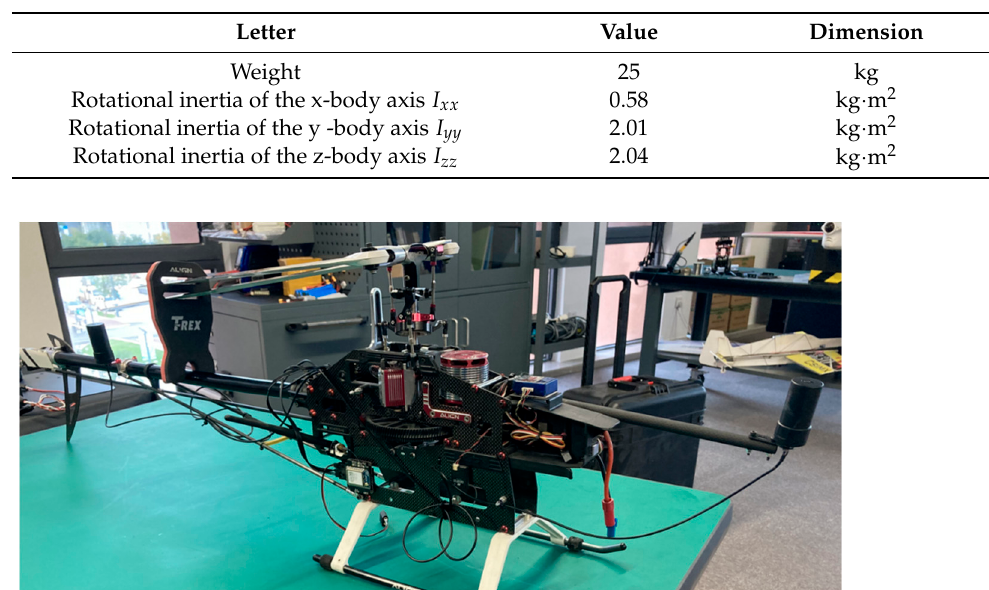
Table 2. The simulation frequency bands and frequency increments under different sea states. Re- printed with permission from ref. [22].